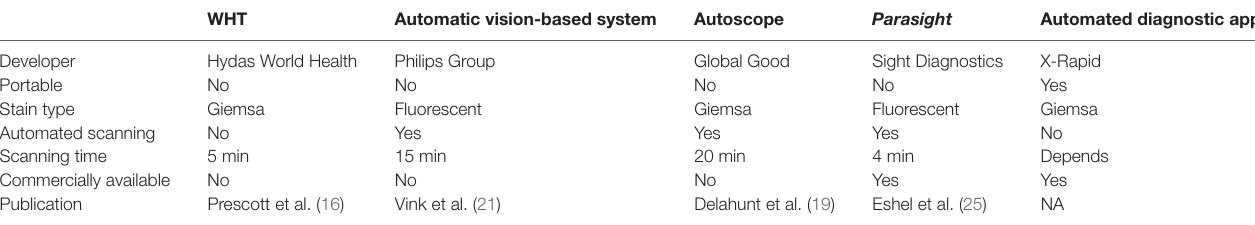
TABLe 1 | Summary of advance computer vision systems discussed in this